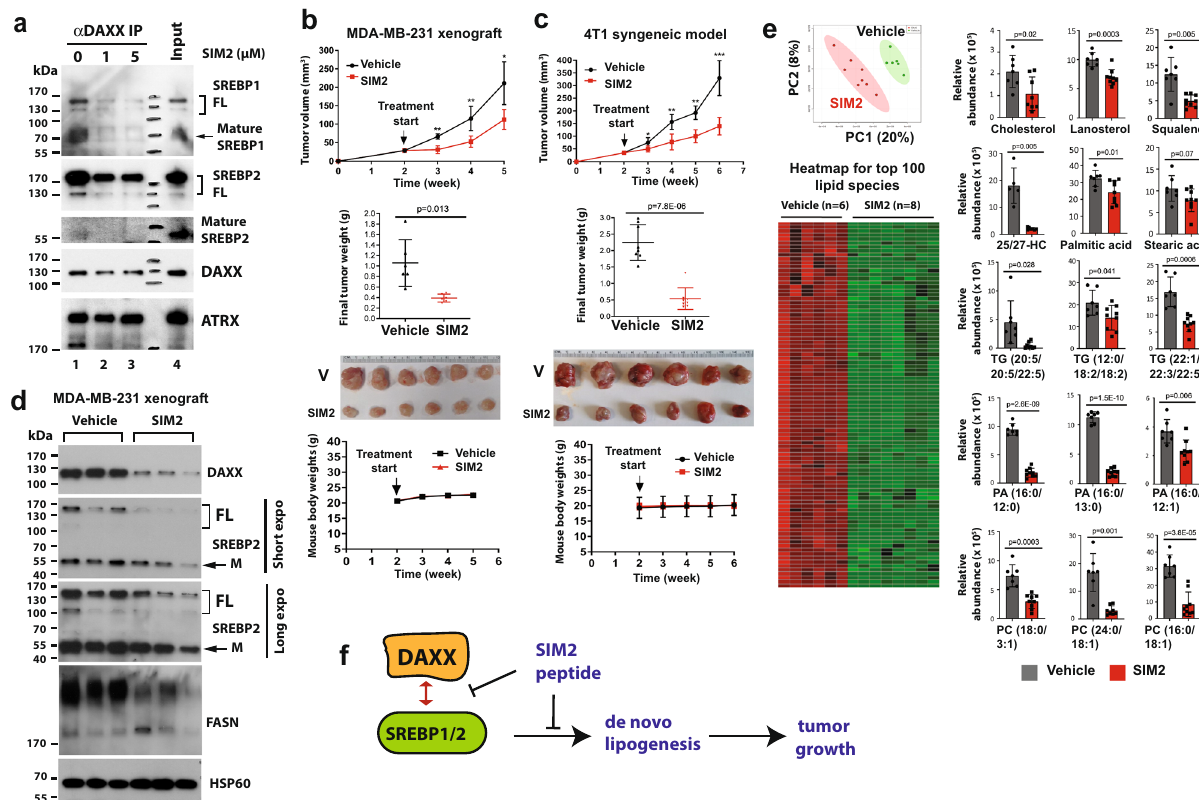
Fig. 8 | The DAXX SIM2 peptide disrupts the DAXX – SREBP interactions and suppresses tumor growth in vivo. a MDA-MB-231 cell extracts were subjected to anti-DAXX IP in the absence (0) or the presence of SIM2 (1 and 5 µ M). The immu- noprecipitates and input were analyzed by immunoblotting. b The MDA-MB-231 cells were implanted into mammary fat pads of female NSG mice ( n =6 tumor- bearing mice).Mice were dosed i.p. daily weekdays for three weeks with vehicle or SIM2 (25mgkg – 1 ). Longitudinal tumor volumes, mouse body weights, endpoint tumorweights,andimagesareshown. c Themousemammarytumor4T1cellswere injectedintomammaryfatpadsoffemaleBALB/cmice( n =6tumor-bearingmice). Mice were dosed as in ( b ). Longitudinal tumor volumes, mouse body weights, endpoint tumorweights,and tumor imagesare shown. d SIM2dosing reduced the expression of DAXX, SREBP2 and FASN in tumors. Protein extracts from three